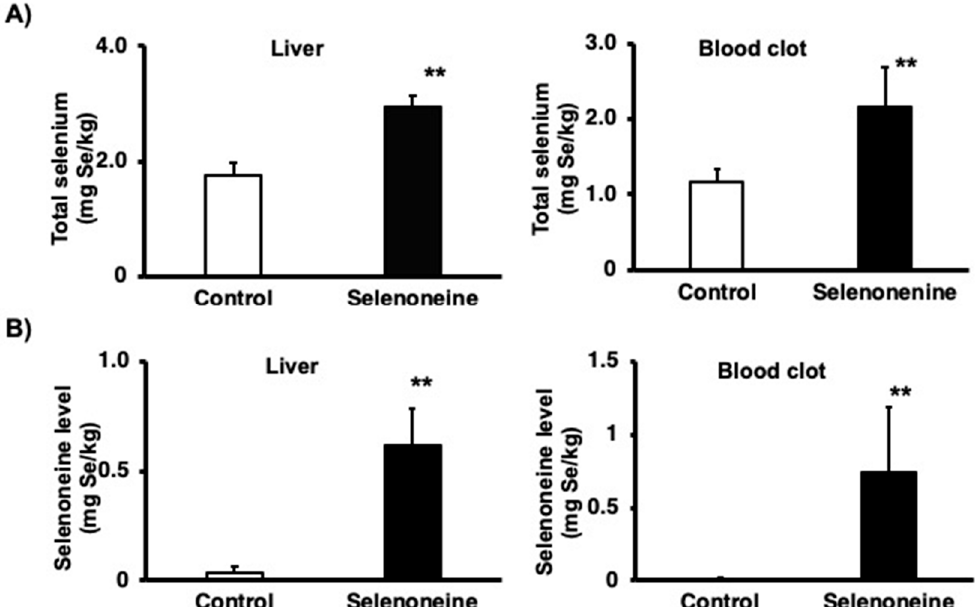
Figure 3. Total selenium and selenoneine concentration. ( A ) Total selenium level. ( B ) Selenoneine level. Mice were fed a diet supplemented with 0.3 mg Se / kg selenoneine for 4 months. The total selenium and selenoneine concentrations were measured using LC-ICP-MS. Values are presented as mean ± SD ( n = 8). Significant differences were assessed using Student’s t -test (**, p < 0.01).